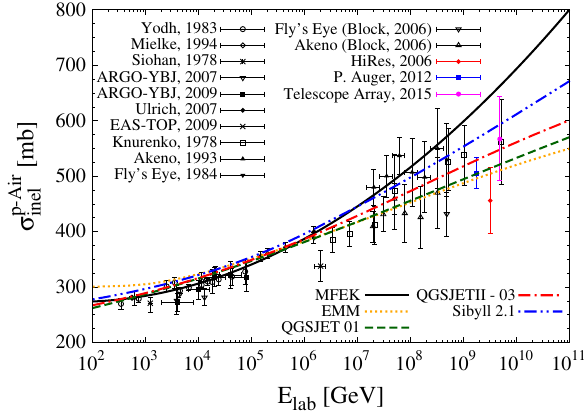
Fig. 1 Energydependenceoftheinelasticproton–aircrosssectionpre- dicted by the distinct phenomenological models discussed in the